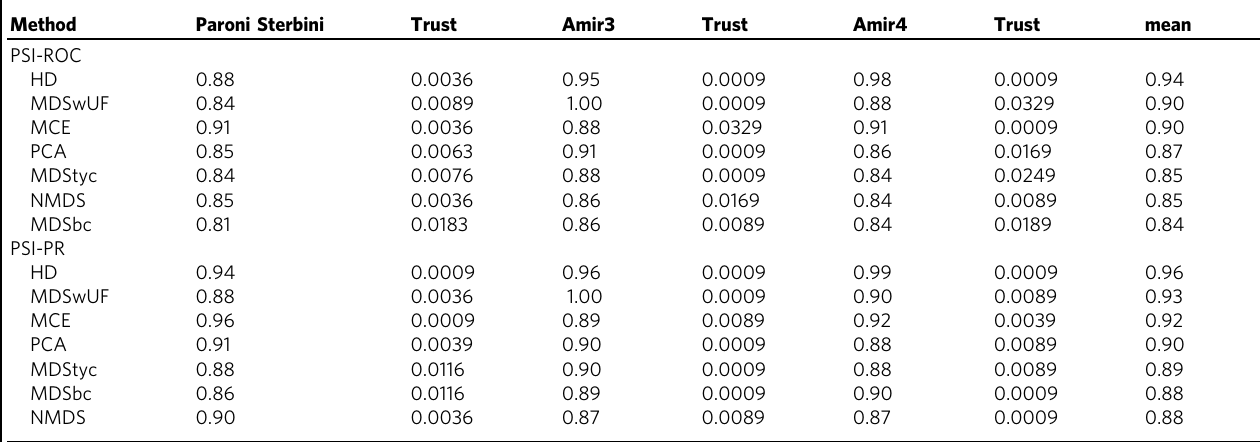
Table 1 Results of unsupervised dimension reduction techniques on the real dataset. Method Paroni Sterbini